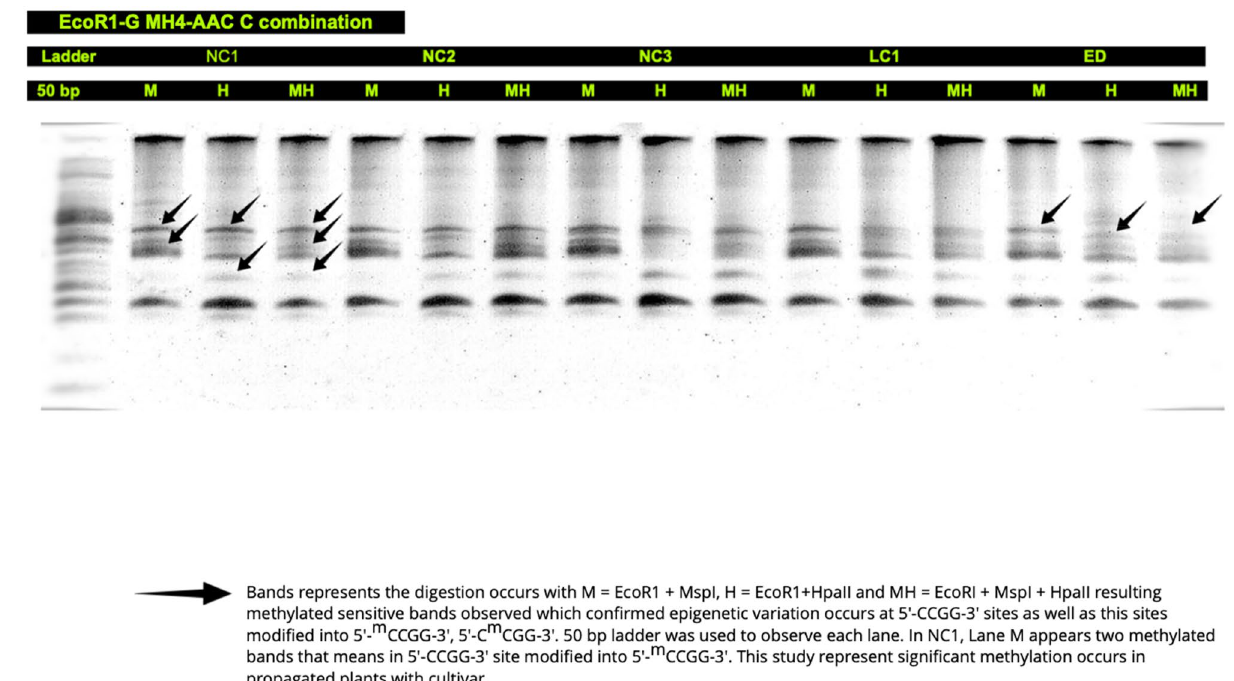
Figure 1. DNA methylation patterns observed in NC1 (node culture-derived shoots from liquid medium), NC2 (node culture-derived shoots from semi-solid medium), NC3 (node culture-derived plants from greenhouse), LC1 (leaf culture-derived plants from greenhouse), and ED (cutting propagated plants from greenhouse) of lingonberry cultivar Erntedank. Selective amplification was carried out using an EcoR1 -G/ MH4-AAC C primer combination. M, H, and MH refer to DNA fragments originating from digestion with combinations of EcoR1 + MspI , EcoR1 + HpaII , and EcoR1 + MspI + HpaII , respectively. DNA bands (marked arrows) present in H digestion lanes but not in M lanes indicate hemi-methylated external cytosine (5’- mCCGG-3’) at 5’-CCGG-3’ sites, whereas DNA bands (marked arrows) present in M digestion lanes but not in H lanes indicate fully methylated internal cytosine (5’-CmCGG-3’) at 5’-CCGG-3’ sites in genomic DNA. Ladder: 50 bp (New England Biolabs Ltd., Whitby, ylation (Fmet) in EcoR1 -G/MH4-AAC C combination. Whereas, in NC1 methylated DNA was marked by a red spot that absent or present in M, H, and MH lane altogether found in EcoR1 -G/MH2-ACT primer combination. Analysis of secondary metabolites and their comparative study.